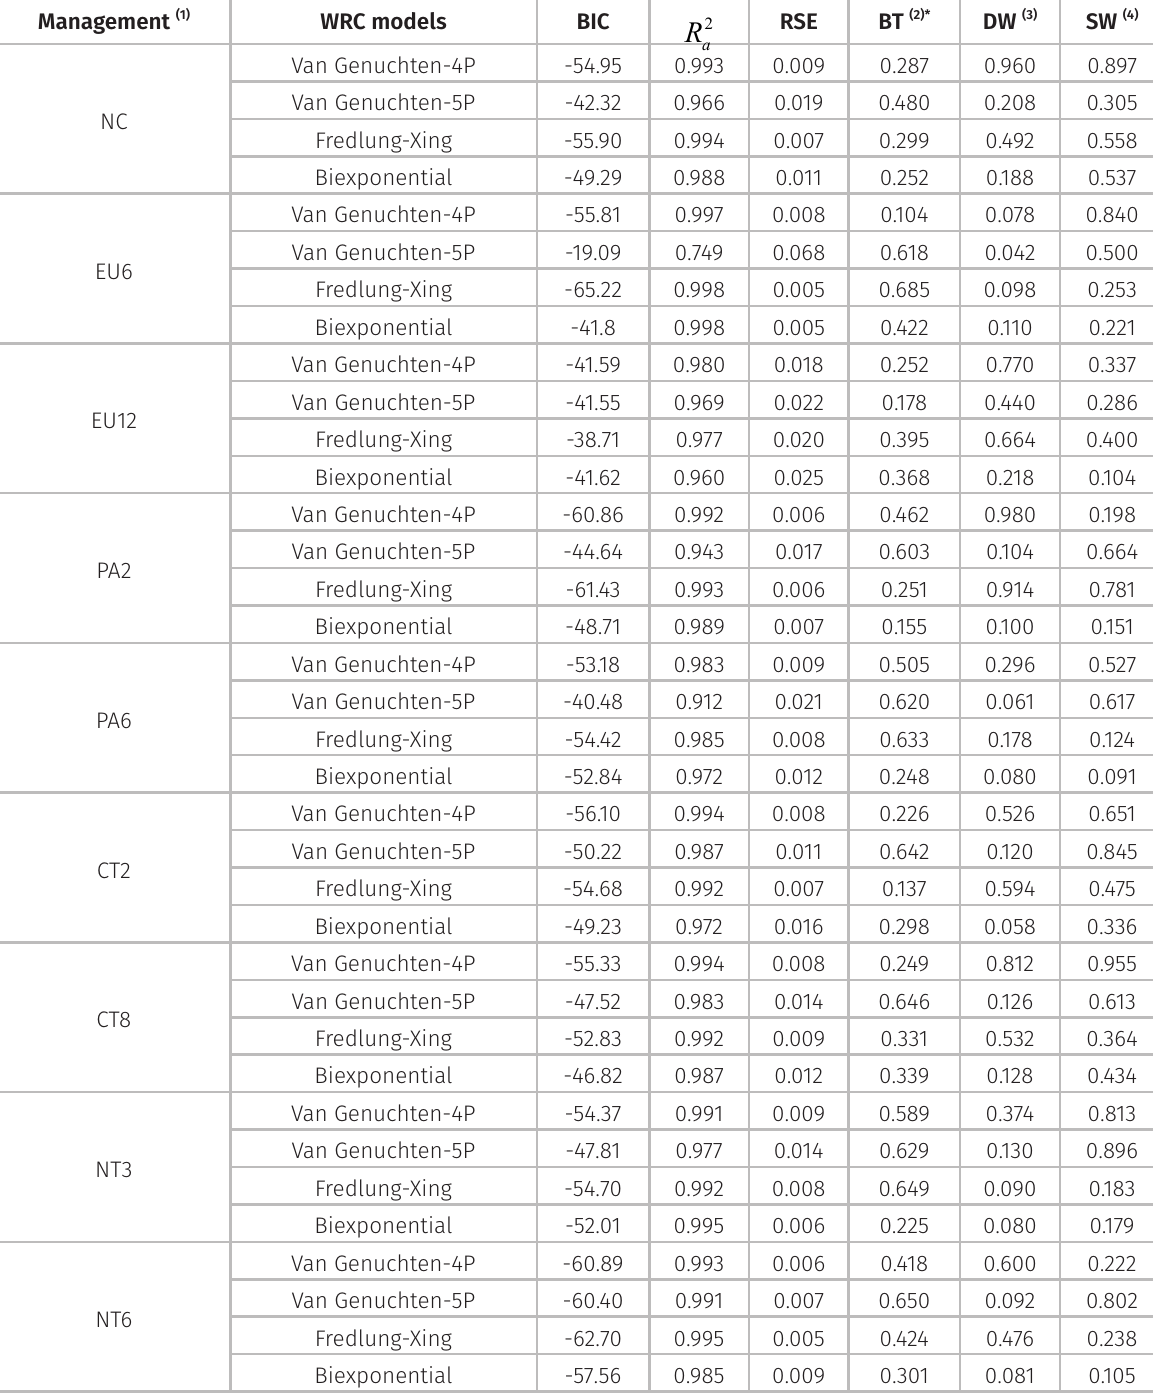
Table IV. Adjustment criteria for soil water retention models (WRC): Bayesian information criterion (BIC), adjusted 2 R ), and residual standard error coefficient of determination ( a